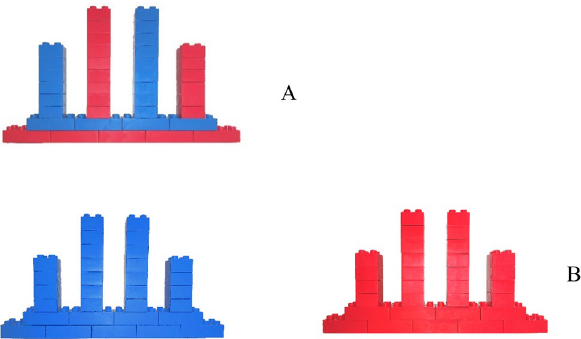
Figure 4. Tower to be constructed in the ( A ) joint condition and ( B ) separate